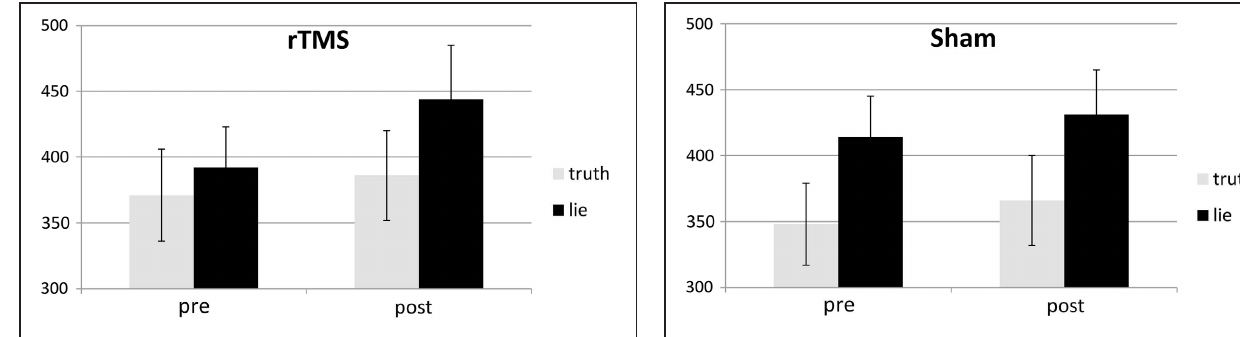
FIGURE 6 | Mean SDs of RTs (ms; ± one SE) for lie and truth trials, pre and post real rTMS.